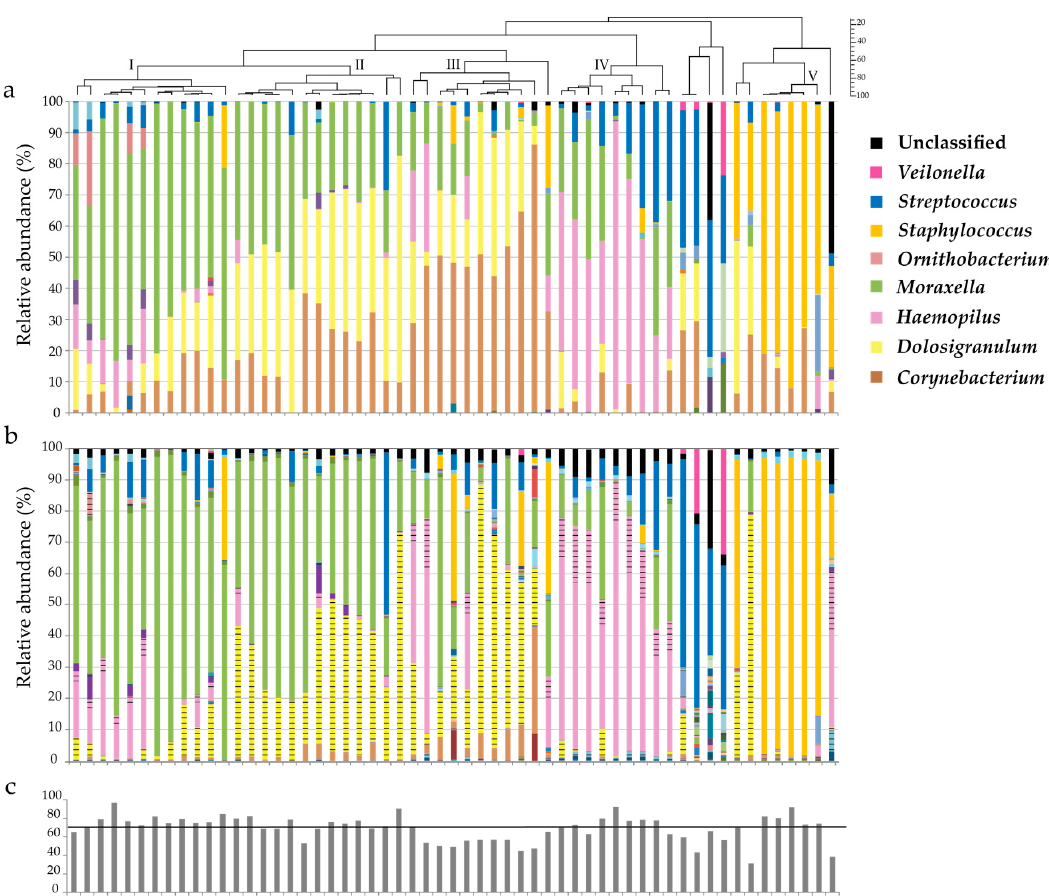
Figure 1. Nasal microbiota profiles generated using nanopore and Illumina 16S rRNA gene sequencing. DNA was isolated from 57 nose swab samples, and 16S rRNA gene sequencing was performed using both Illumina ( a ) and nanopore ( b ) technologies. Each bar in the graph represents a nasal microbiota profile from a single individual. The dashed lines in ( b ) represent genera that, by default, were reported as unclassified at genus level in the EPI2ME report but were identified when next to reads with a top three blast hit with one genera (num_genus_taxid is 1); reads with a top three blast hit with two genera (num_genus_taxid is 2) were also included. A phylogenetic tree was generated by Pearson / UPGMA clustering of bacterial genera in microbiota profiles, as determined using Illumina sequencing. To compare between the two techniques, the sample order of the samples that were sequenced with the Oxford Nanopore platform was matched to the sample order of the samples that were sequenced with the Illumina platform, and the percentage of agreement was calculated for each nose swab sample ( c ). The horizontal black line in ( c ) indicates the mean percentage of